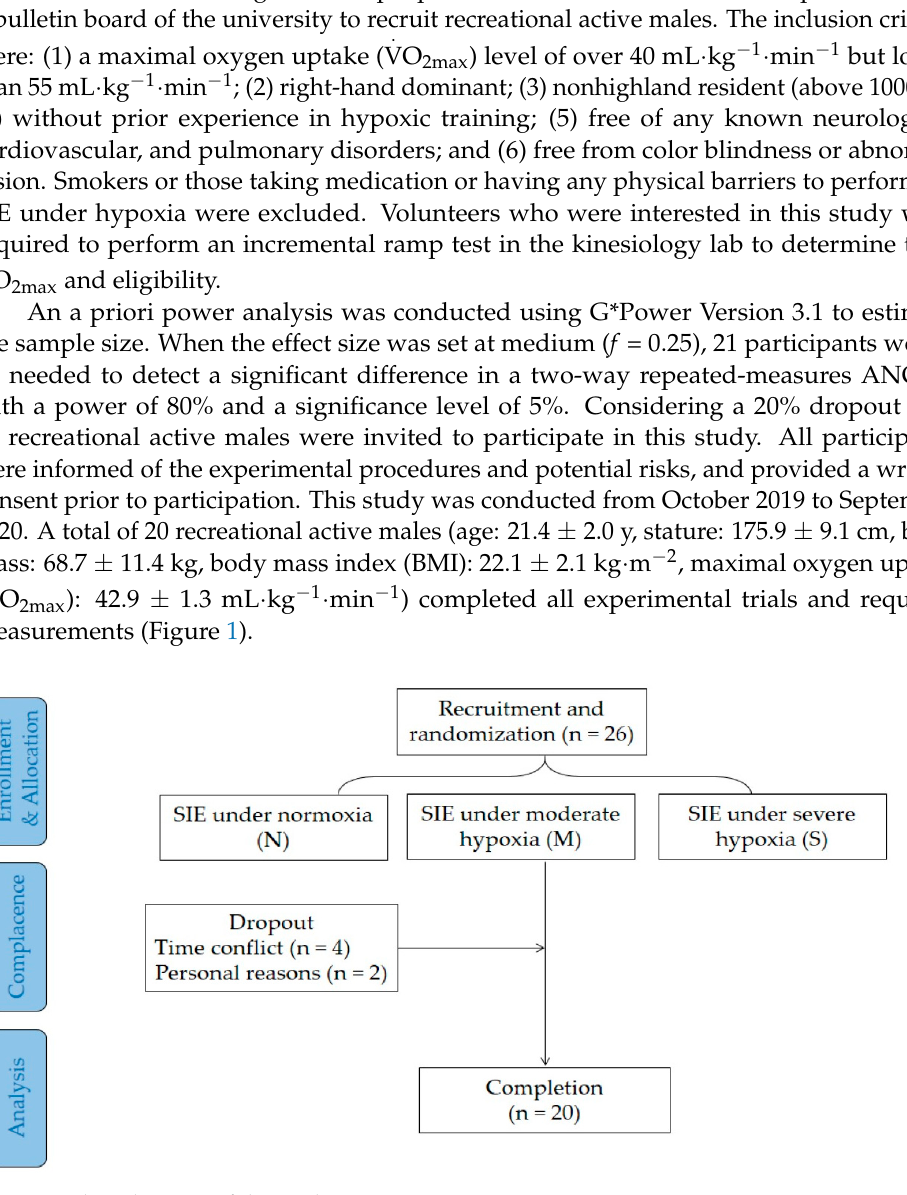
Figure 1. Flow diagram of the study.